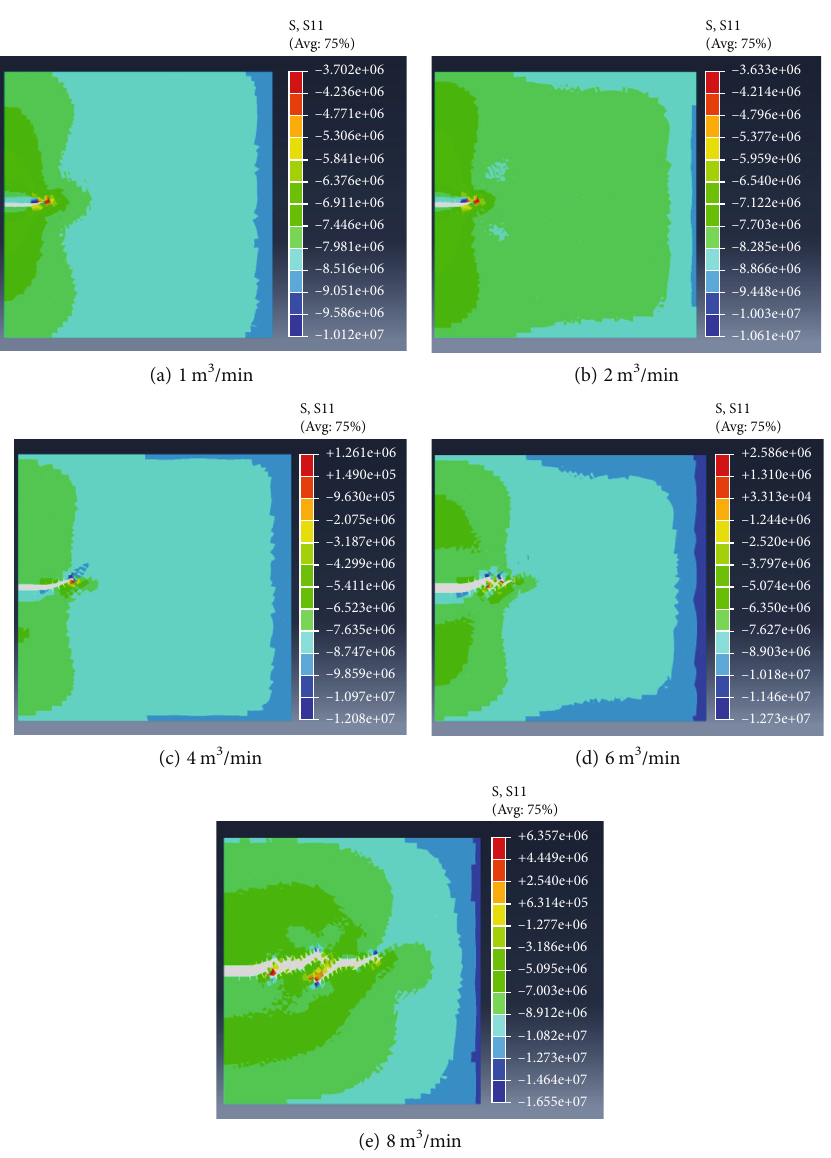
° and at the rate of 1-8m 3